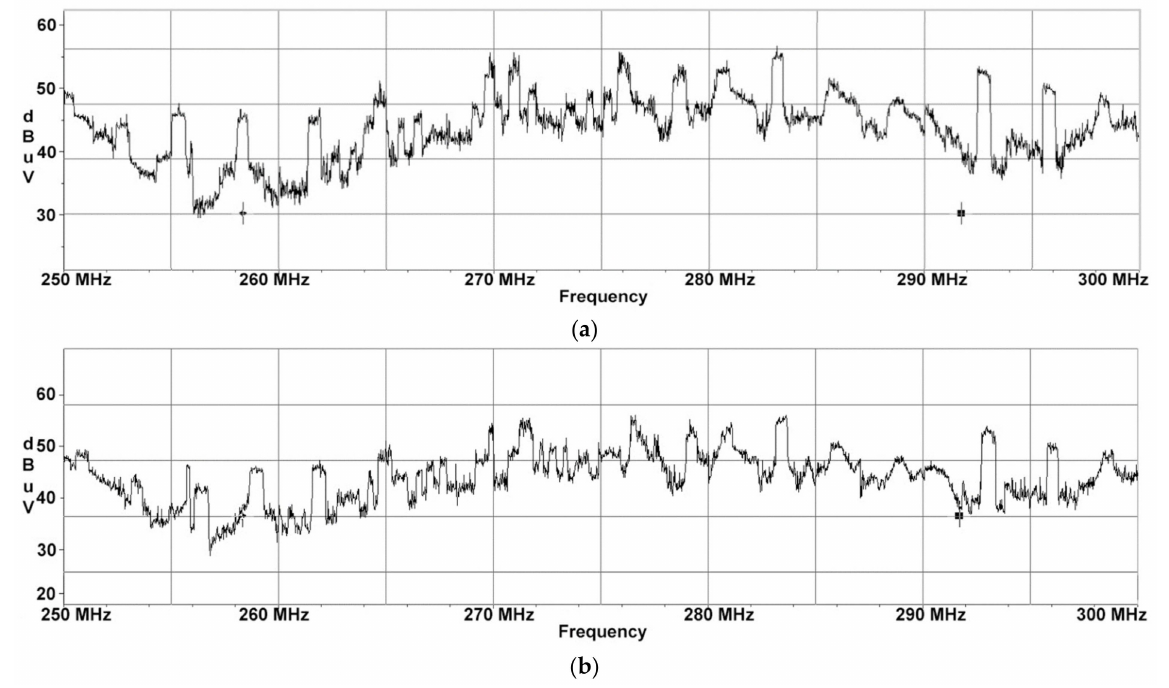
Figure 3. HP display unit: ( a ) frequency sweeps performed for test signal consisting of 3 horizontal bars equal in width; ( b ) frequency sweeps performed for test signal consisting of 1 thick horizontal line and 3 thin horizontal lines equal in